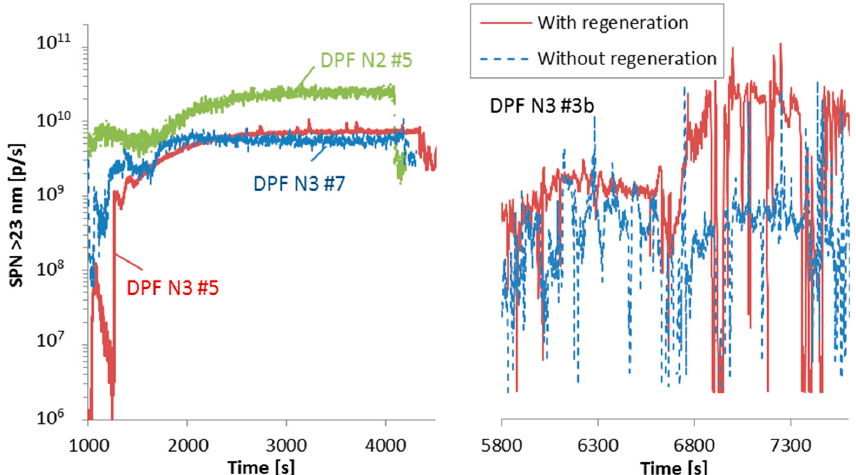
Figure 8. Examples of regeneration events. Left : Dashboard activated regeneration for three parked vehicles (time axis shifted for better visualization). Each color line refers to a different vehicle. Right : Two similar trips of vehicle DPF N3 #3b; one with regeneration, the other without.